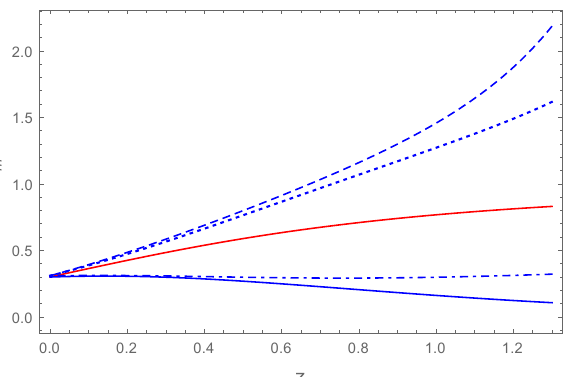
Figure 2. Variation of the dimensionless matter density, Ω m , as a function of z for K µν = ( β 2 R + γ 2 T ) R µν with different values of the parameters b 2 and g 2 : b 2 = 0.044 and g 2 = − 0.01 (solid curve), b 2 = − 0.0076 and g 2 = 0.001 (dotted curve), b 2 = − 0.013 and g 2 = − 0.0007 (dashed curve), and b 2 = 0.013 and g 2 = 0.03 (dot-dashed curve). The evolution of the matter density in the standard Λ CDM model is shown by the red solid